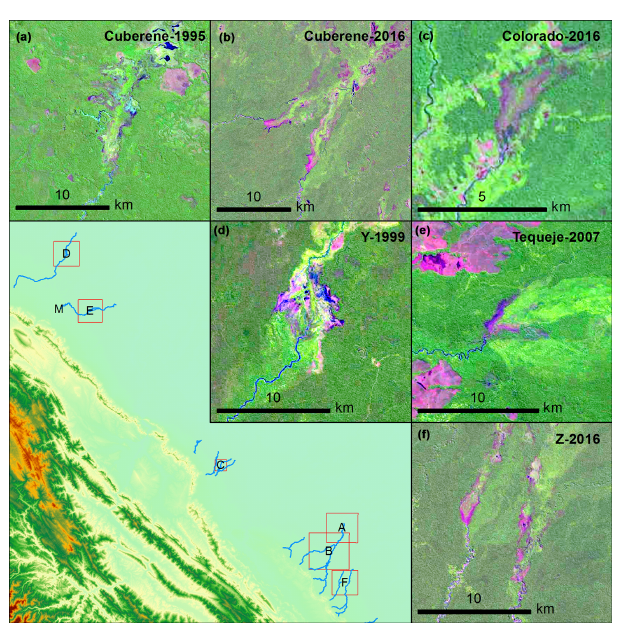
Figure 2. Examples of forest die-off events like the one described in Gullison et al. (1996). The reddish plumes diverging from the river channel indicate dead forest. Here, trees have lost their leaves and this causes a fall in near-infrared reflectance, which is shown in green in the RGB composition of the Landsat imagery (a–f) , and an increase in mid-infrared reflectance (shown in red), which is mostly due to sediments. Non-forested, light green areas are cov- ered by pioneer species; forested, light green areas are young sec- ondary forests that have regrown after disturbance; forested, dark green areas are old-growth forests. Non-forested, reddish areas are savannah. Blue/black areas are water. All rivers flow from south- west to